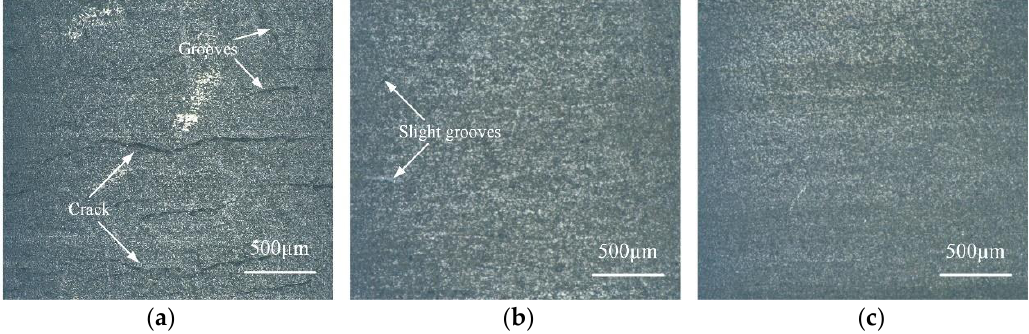
Figure 6. Comparison of surface morphology of SiC. ( a ) Traditional turning surface, ( b ) Surface optimization by orthogonal method, ( c ) Surface optimization by RSM.